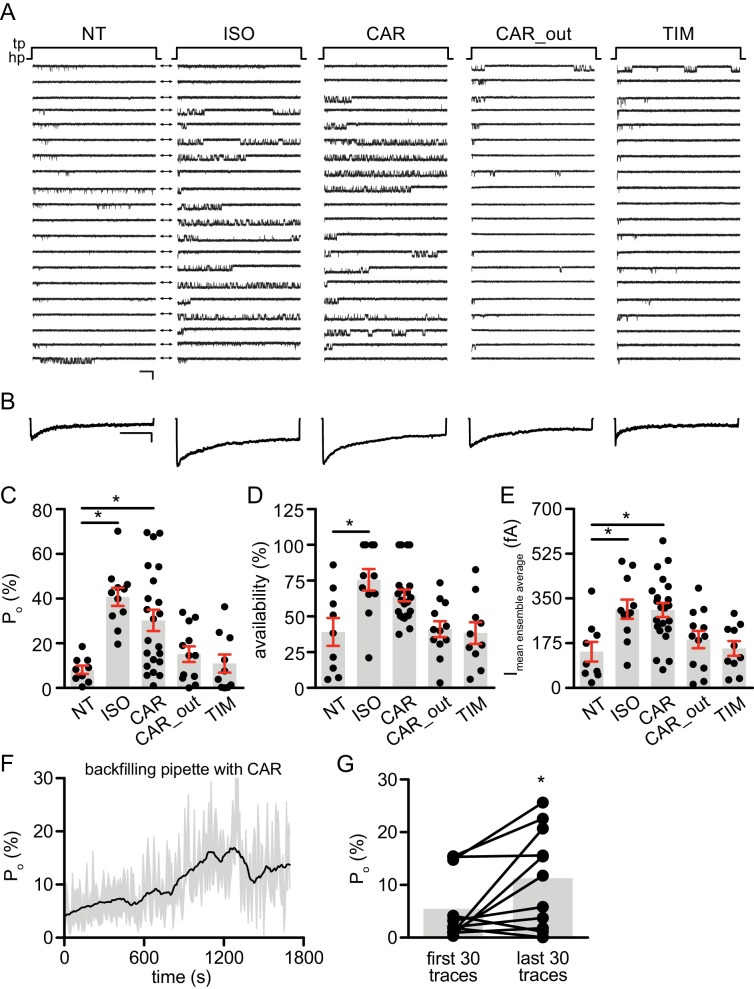
Carvedilol augments LTCC CaV1.2 channel activity in neurons.(A) Representative single channel recordings of LTCC CaV1.2 currents using 110 mM Ba2+ as charge carrier in rat hippocampal neurons on 7–10 days in vitro (DIV) after depolarization from −80 (hp) to 0 mV (tp) in control patches (NT), patches containing 1 μM isoproterenol (ISO), 1 μM carvedilol (CAR) or 1 μM timolol (TIM) in the patch pipette or after addition of 1 μM CAR to the bath while the patch pipette contained a control pipette solution (CAR_out). Shown are 20 consecutive sweeps from representative experiments. Arrows throughout the figure indicate the 0-current level (closed channel). Scale bar denotes 2 pA and 200 ms. (B) Ensemble average currents as determined from all sweeps recorded for all the experimental conditions. Scale bar denotes 50 fA and 400 ms. (C–E) Mean ± s.e.m. for (C) Po (%), (D) availability (i.e. likelihood that a sweep had at least one event) (%) and (E) the mean ensemble average current (fA) for each experimental condition. *p<0.05 with Kruskal Wallis – Dunn’s multiple comparison test. Sweep and n numbers as well as summary statistics are in Supplementary file 1. (F) Ensemble Po versus time measurements obtained with a pipette backfilled with 1 μM CAR. The solid dark line represents the mean Po over time and the gray area is the s.e.m. at each time point. The mean line was smoothed to 15 neighbors on each size with a second order polynomial smoothing in PRISM for representation purposes only. (G) Mean Po of the first 30 traces versus the last 30 traces obtained with a pipette backfilled with 1 μM CAR. The gray boxes highlight the mean on each group. n = 11 patches. *p<0.05 with Mann-Whitney test.Figure 5—source data 1.Excel spreadsheet containing the individual numeric values of Po, availability and current analyzed in Figure 5C-G.